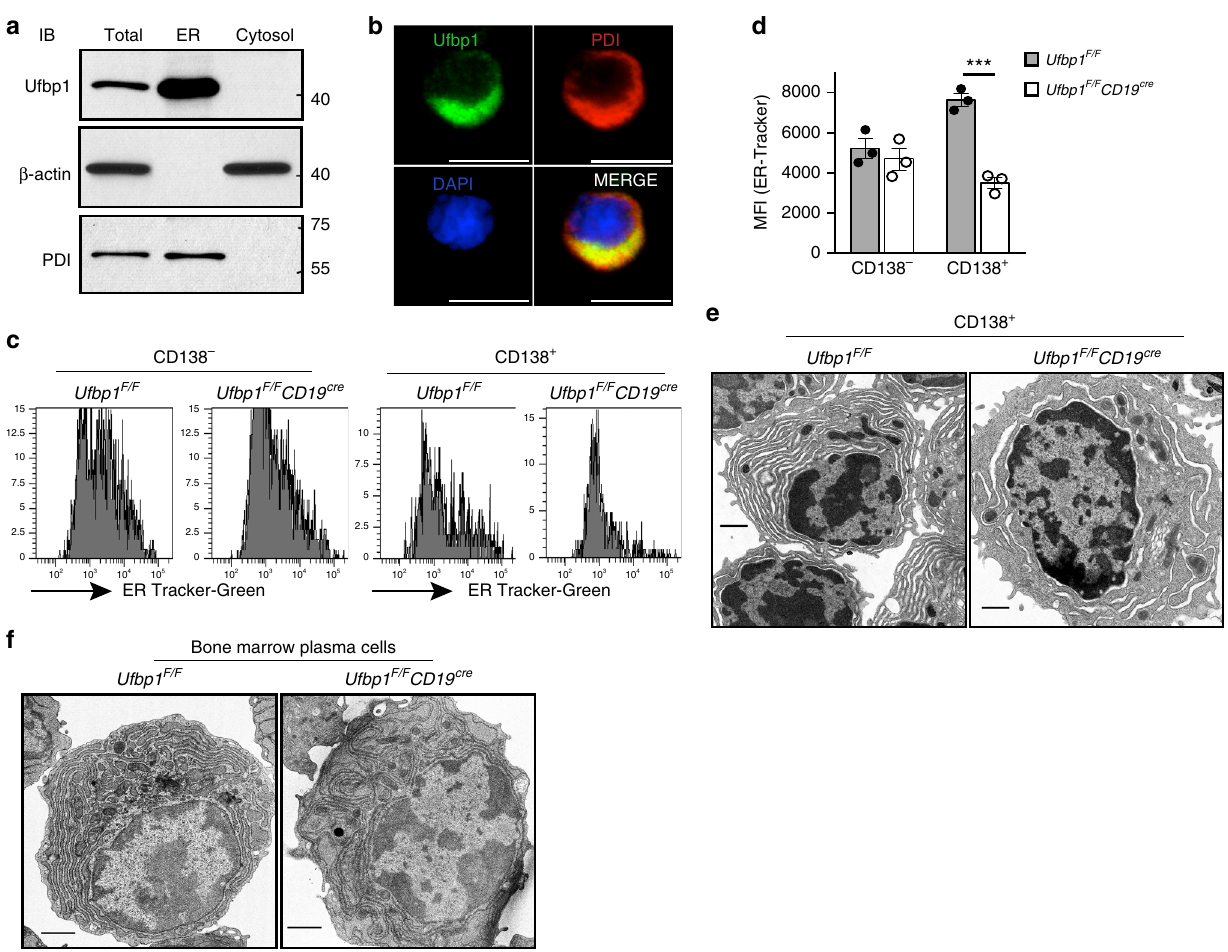
Fig. 4 Ufbp1 is required for endoplasmic reticulum (ER) expansion in antibody-secreting cells. a Naive B cells from wild-type mice were activated with lipopolysaccharide (LPS) for 3 days. Total, ER, and cytoplasmic fractions were immunoblotted with antibodies against indicated molecules. PDI is used as ER marker, whereas β -actin is a marker for cytoplasm. b Visualization of Ufbp1 and PDI co-localization in LPS-activated B cells by fl uorescent microcopy. Scale bars are 5 µ m. c Naive B cells from Ufbp1 F/F and Ufbp1 F/F CD19 cre mice were cultured with LPS for 3 days. Shown is the fl ow cytometric staining of ER-tracker in CD138 − and CD138 + cells. d Quanti fi cation of ER-tracker staining in CD138 − and CD138 + cells in c ( n = 3 mice/genotype). MFI mean fl uorescent intensity. e Transmission electron microscope images of CD138 + cells sorted from LPS-stimulated B cell cultures from Ufbp1 F/F and Ufbp1 F/F CD19 cre mice. Scale bars are 1 µ m. f Transmission electron microscope images of bone marrow plasma cells isolated from mice of indicated genotype. Scale bars are 1 µ m. *** P < 0.001. Error bars represent mean ± standard error. Unpaired Student ’ s two-tailed t -test was used. A representative of at least two experiments